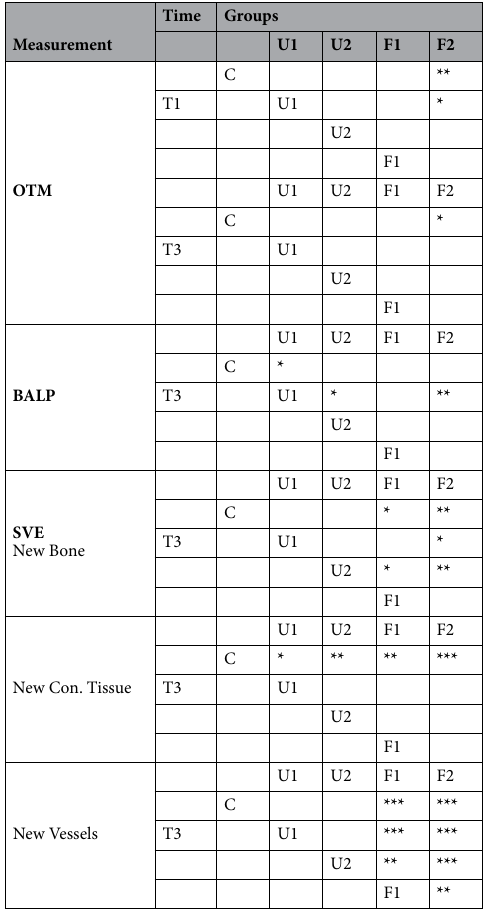
Table 2. Statistically significant differences among the five groups using Tukey’s HSD multiple-range test (filled squares show significantly different pairs at the 95% confidence level, * p < 0.05, ** p < 0.01, *** p <